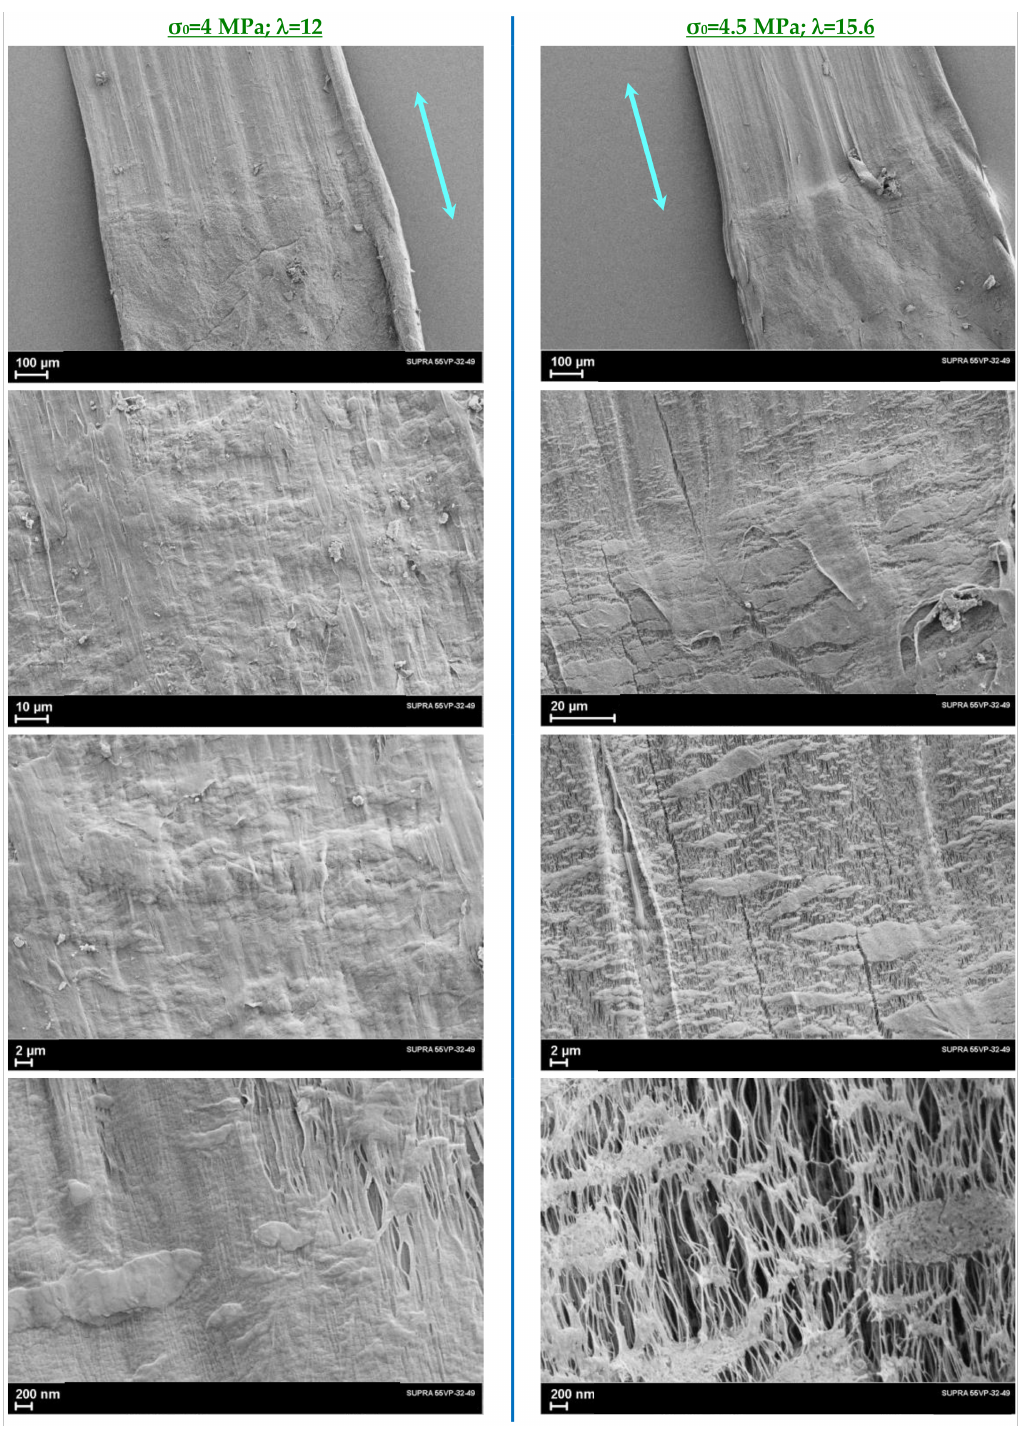
Figure 7. SEM images of the necking region in the UHMWPE films recorded at different magnifica- tions: left side — λ = 12, initial applied stress σ 0 = 4 MPa; right side — λ = 15.6, σ 0 = 4.5 MPa. Blue arrows indicate drawing direction of the